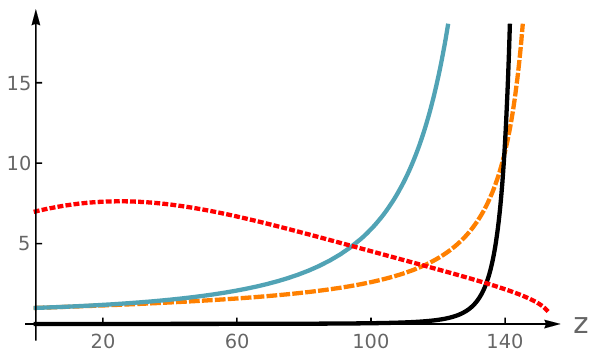
Figure 2 . A numerical dS solution. It starts from an O8 -plane (on the left) and ends at the 4 + boundary of the hole produced by an O6 (cid:0) -plane (on the right). The functions are e 4 W (turquoise), e 4 (cid:30) (black), e 2 (cid:21) 3 (orange, dashed) and e 2 (cid:21) 2 (red, dashed). On the right, the functions behave as in equation (3.33). The numerical constants that produce the solution in this plot are (cid:3) = 2 : 7 (cid:2) 10 (cid:0) 3 , (cid:20) 3 = (cid:0) 2 : 1 (cid:2) 10 (cid:0) 1 , a 1 = 9 : 02, a 2 = 3 : 5 (cid:2) 10 2 , q 0 = (cid:0) 2 : 86, N = (cid:0) 275 and n 0 = (cid:0)